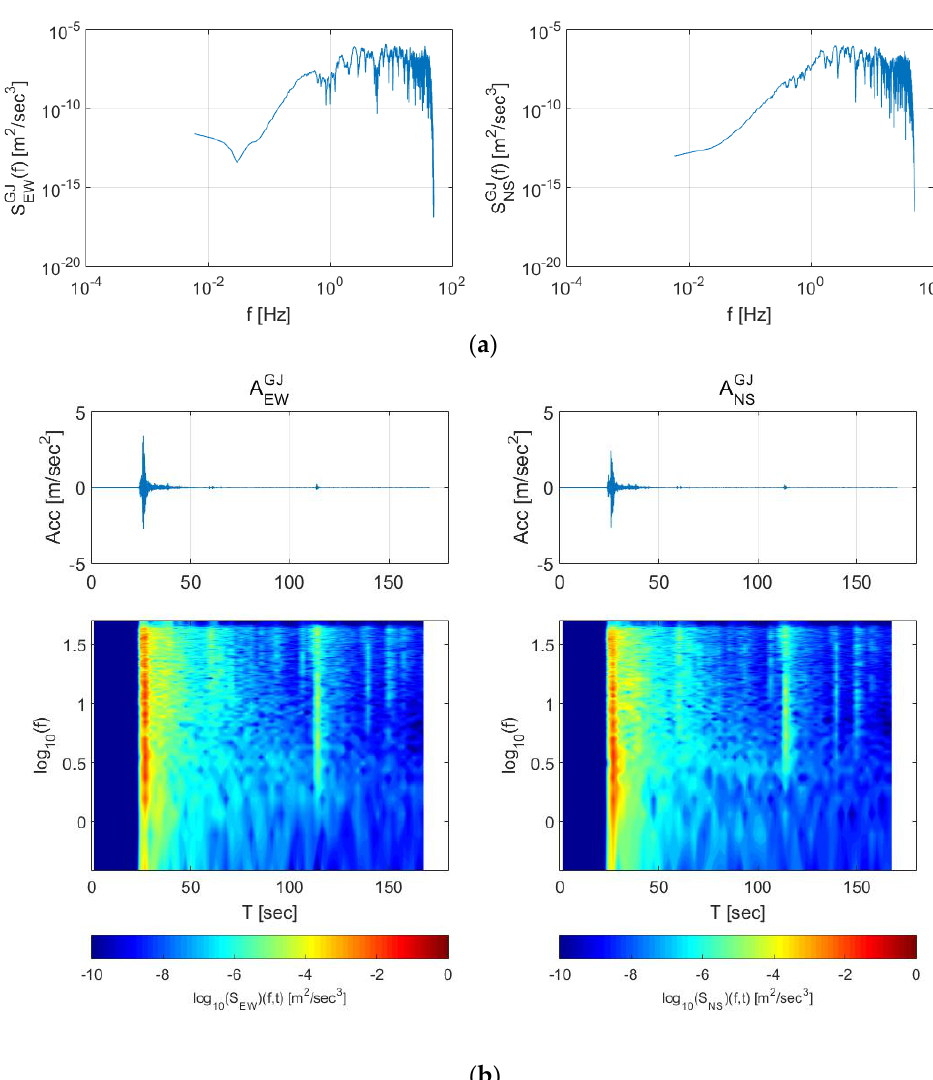
Figure 11. Spectral characteristics of the Gyeongju earthquake presented as ( a ) Power Spectral Density (PSD) and ( b ) spectrogram.